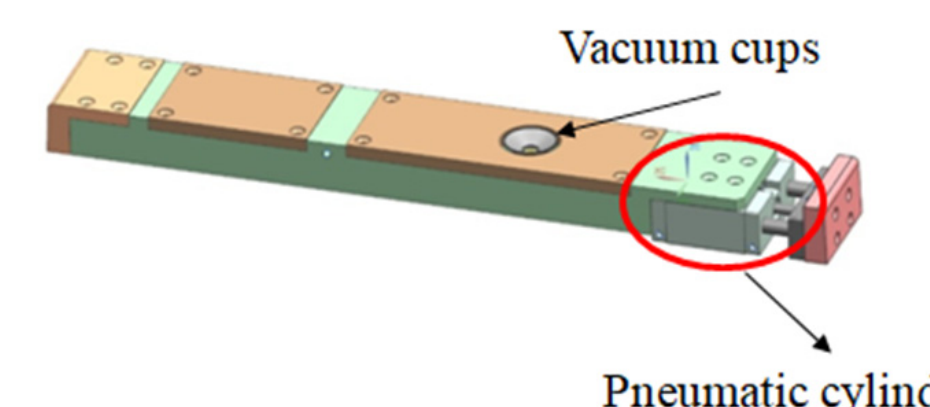
Figure 15. Identifying the problem of centering.